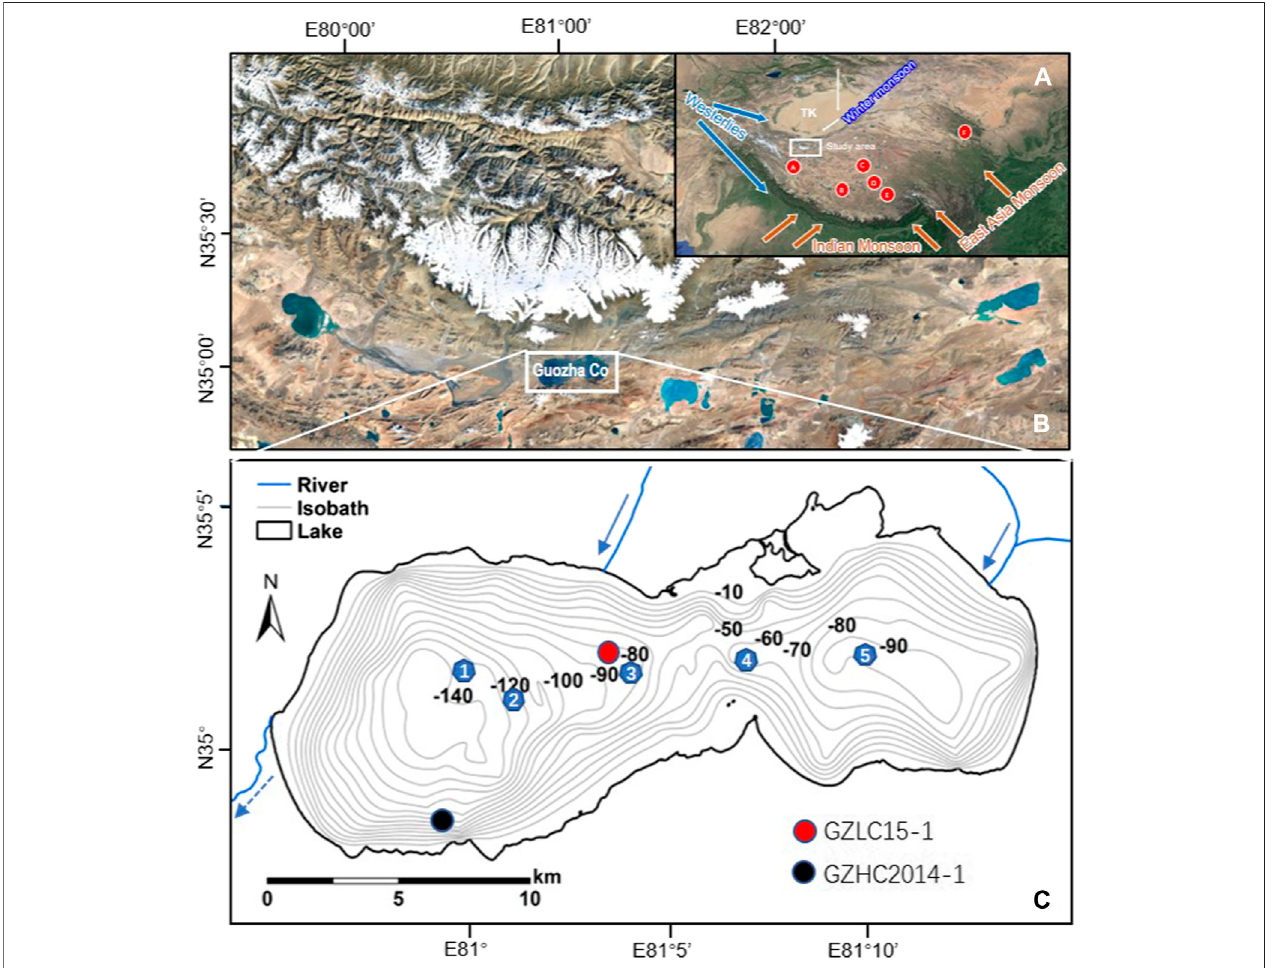
FIGURE1|(A) LocationofGuozhaCoandtheotherlakesreferredtointhisstudy.TK-TaklimakanDesert.A:BangongCo;B:TaruoCo;C:BuroCo;D:LinggeCo; E: Selin Co; F: Qinghai Lake; (B) Relative positions between Guozha Co and glacier; (C) Isobath map showing sampling sites of surface lake water(blue number), the cores GZLC15-1, this study and the core GZHC2014-1 by Li et al. (2021).